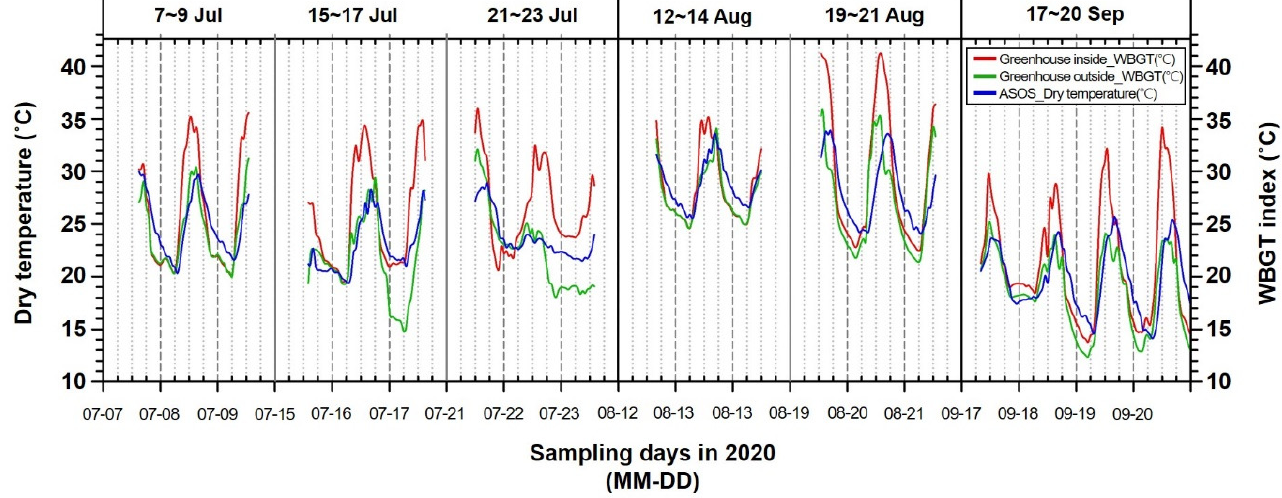
Figure 2. Time-series graphs of the wet-bulb globe temperature (WBGT) index inside and outside greenhouses and of the dry-bulb temperature from Automated Synoptic Observing Systems (ASOS) data for 2020.